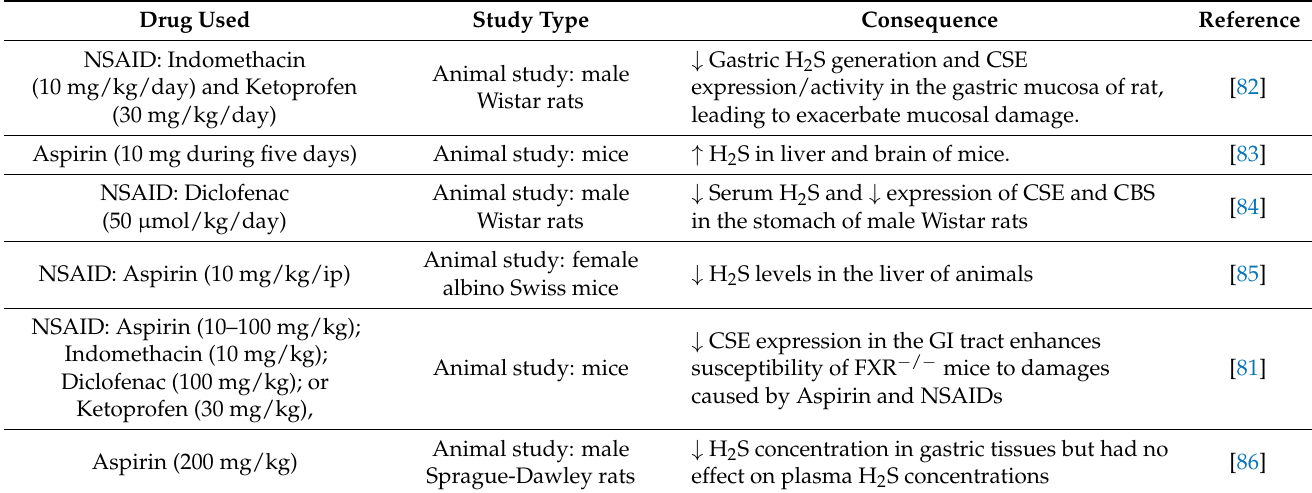
Table 1. Studies utilizing animal and/or cell-culture models to explore the impacts of common pharmacological drugs on H 2 S